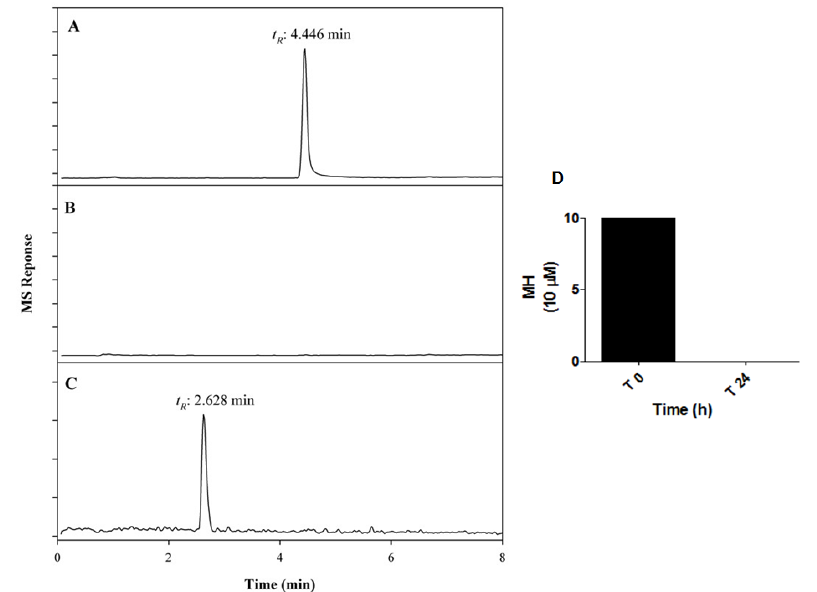
Figure 2. Quantification of MH uptake by medaka embryos by liquid chromatography-mass spectrometry (MS). This figure is a typical MS profile for the analysis of 10 μM MH uptake following 24 h-incubation with embryos, and maintained at 26 ± 1 °C. The amount of MH disappearance from the conditioned media was measured at time 0 h and time 24 h. Selected ion monitoring (SIM) at m / z 281 shows signals for MH at time 0 h ( A ) and time 24 h ( B ). ( C ) The unknown molecule in MS scan mode. ( D ) The amount of disappearance of MH following 24 h incubation with